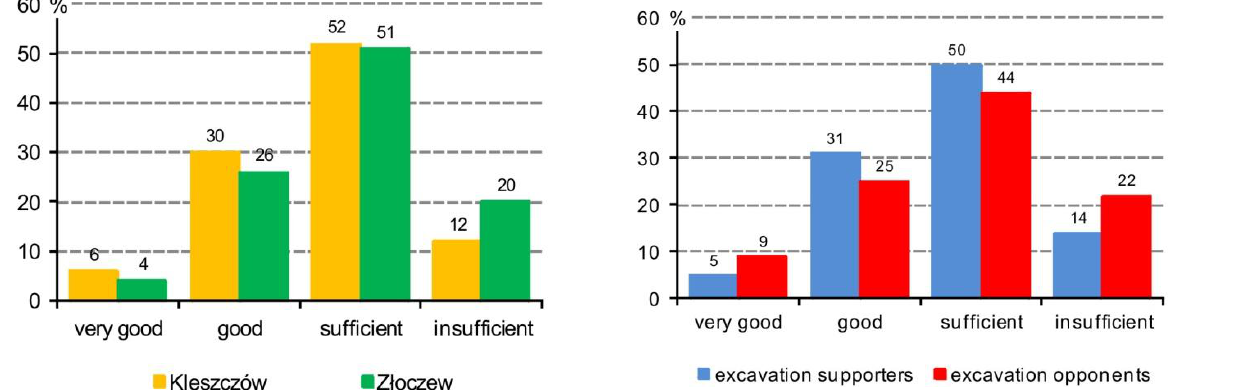
Fig. 1. How do you assess your knowledge level about brown coal mining, its economic role and its influence on the environment? The inhabitants of the Kleszczów community (n = 300) and the Złoczew community (n = 302) separately (Source: Telephone interviewing (CATI), January-February 2012)